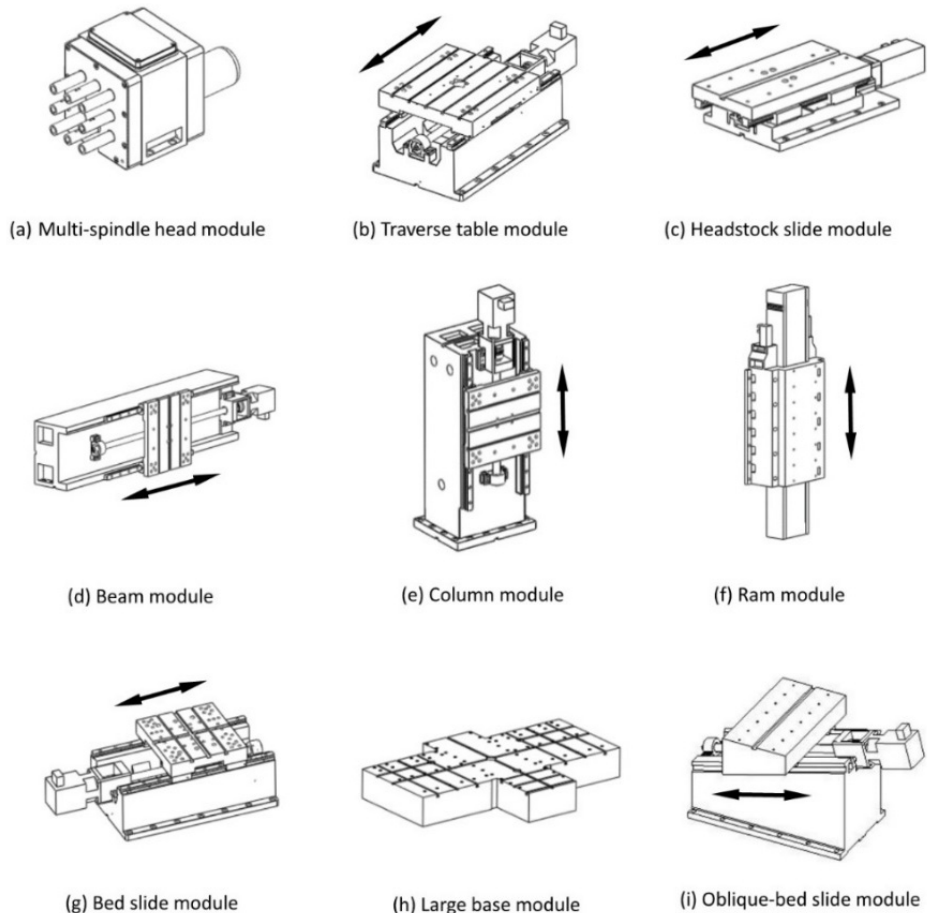
Figure 15. Several generated autonomous functional modules.